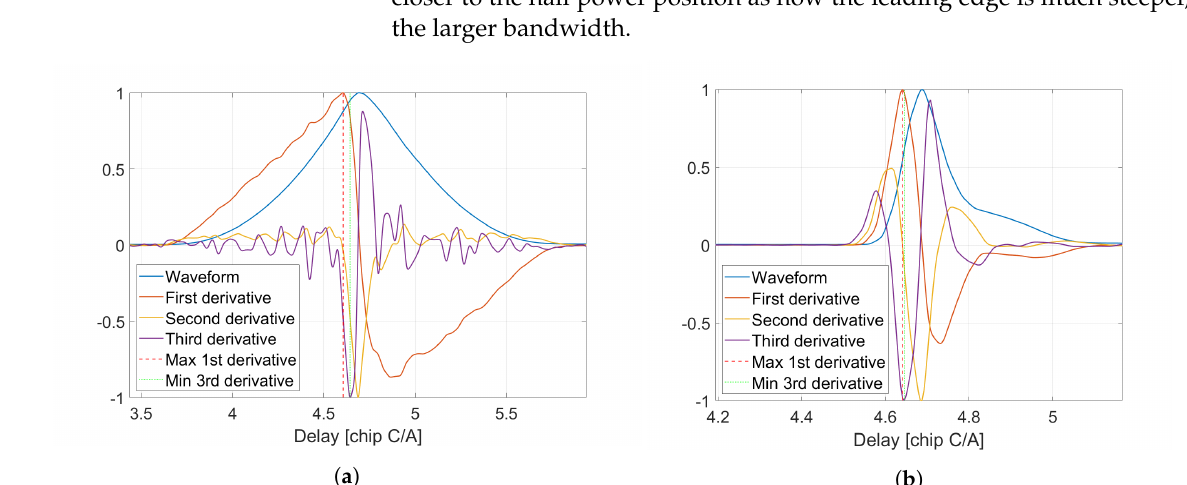
Figure 12. Sample of a normalized ( a ) L1, and ( b ) L5 cGNSS-R reflected waveform acquired by MIR, and its first and third derivatives. Computed with T coh = 1 ms and T incoh = 100 ms.